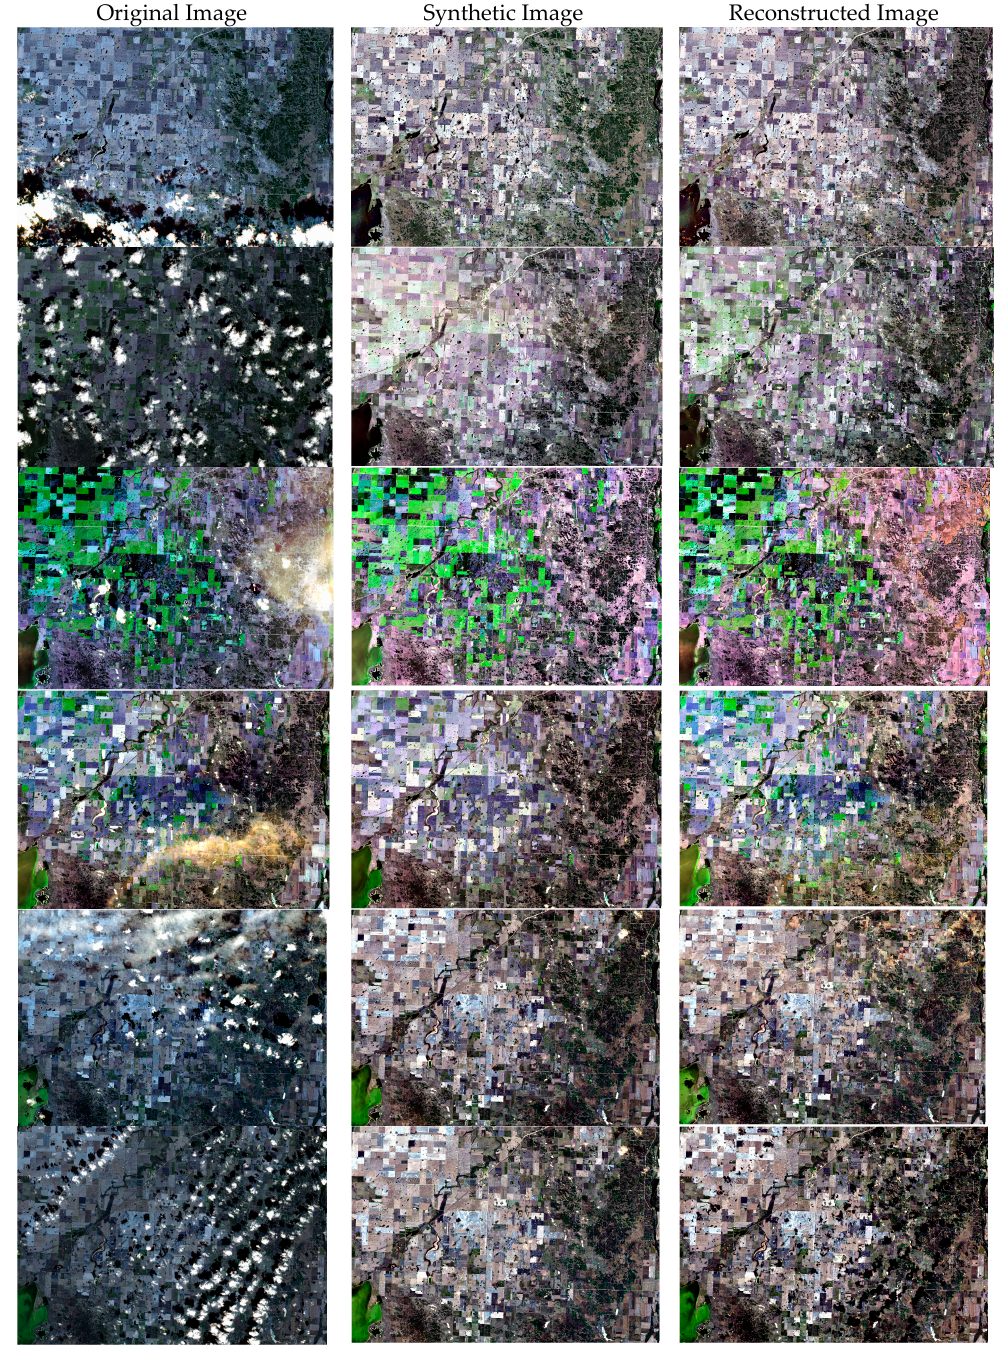
Figure 8. Comparison of the original cloud contaminated, synthetic, and reconstructed cloud ‐ free Sentinel ‐ 2 images on the dates of 21 May, 25 June, 30 July, 21 August, 3 October, and 5 October 2018 (top down).